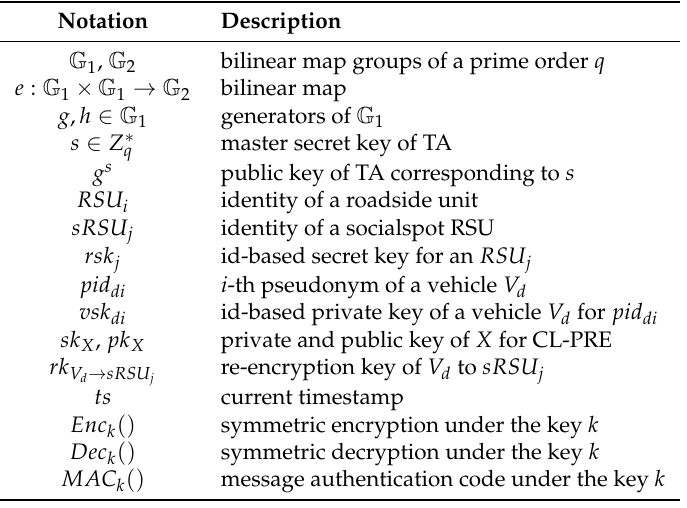
Table 1. Notations and